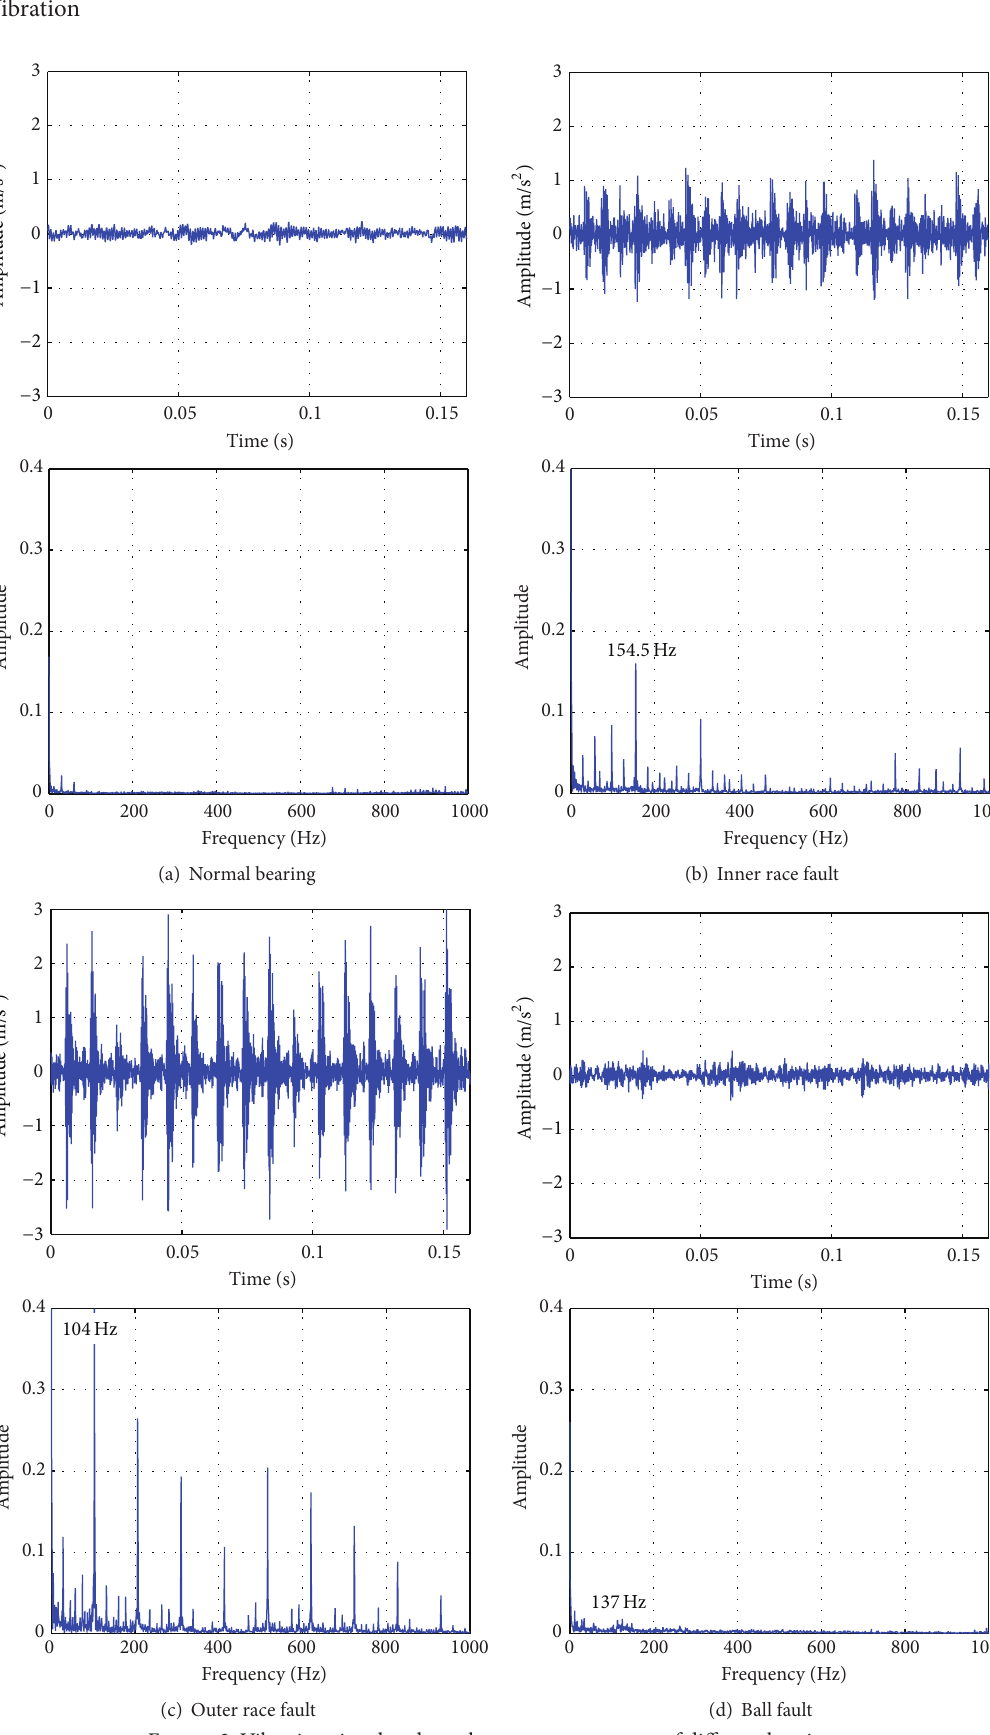
Figure 2: Vibration signal and envelope power spectrum of different